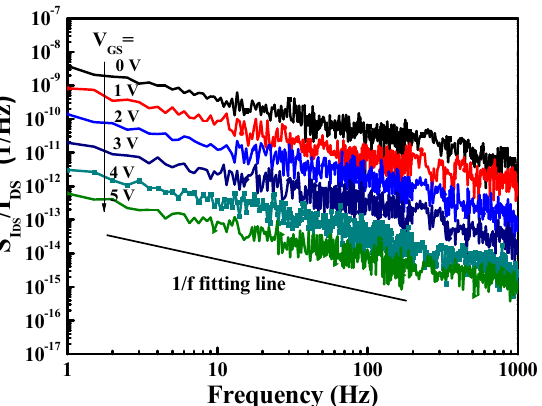
Figure 7. Short-circuit current gain and maximum available power gain as a function of frequency of MOSHEMTs with multiple-mesa-fin-channel array.